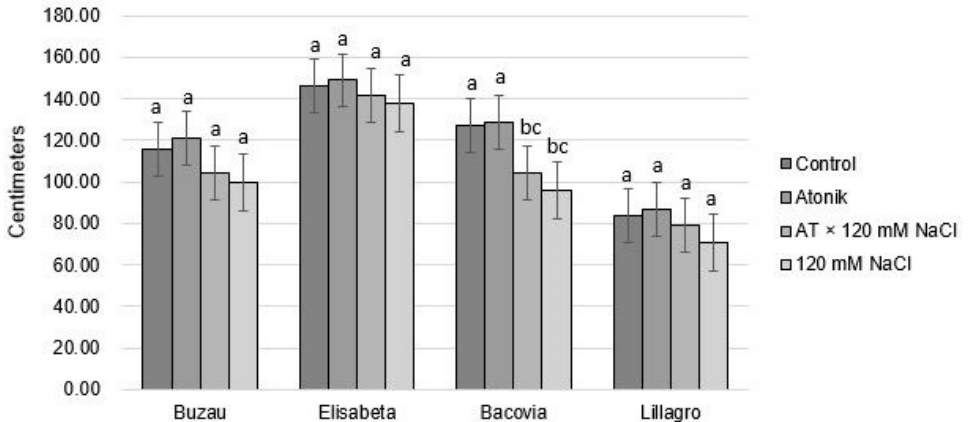
Figure 2. The effect of Atonik biostimulant on the height of tomato plants under saline stress after the second treatment. Different letters mean significant differences, according to the Tukey test. Er- ror bars indicate ±SD.